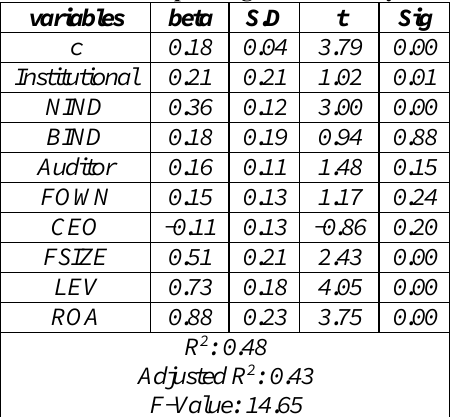
Table 3. Multiple Regression